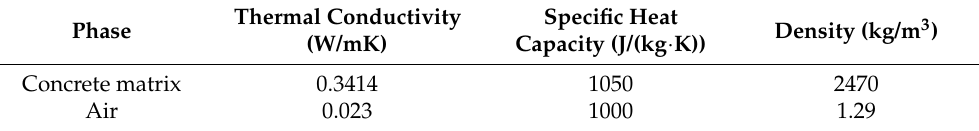
Table 5. Phase parameters of NAAC.